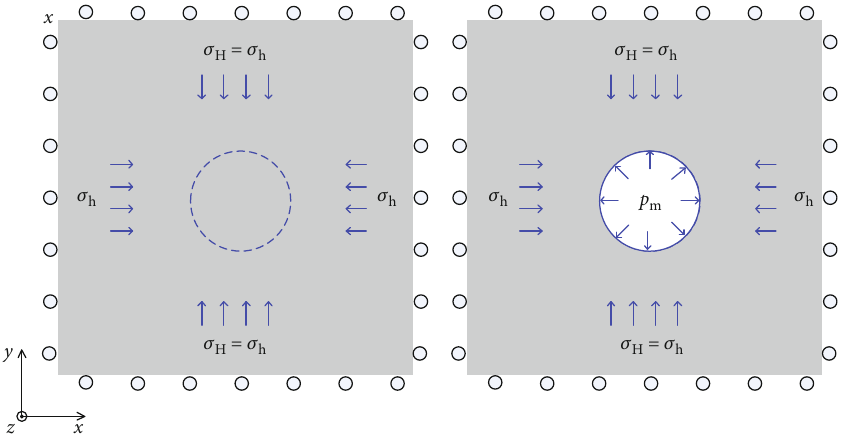
Figure 1: Sketch of the wellbore stability analysis problem: (a) before drilling; (b) after